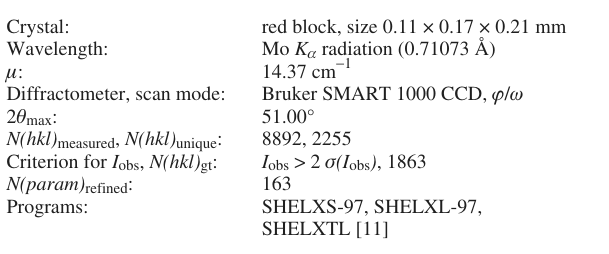
Table 1. Data collection and handling.